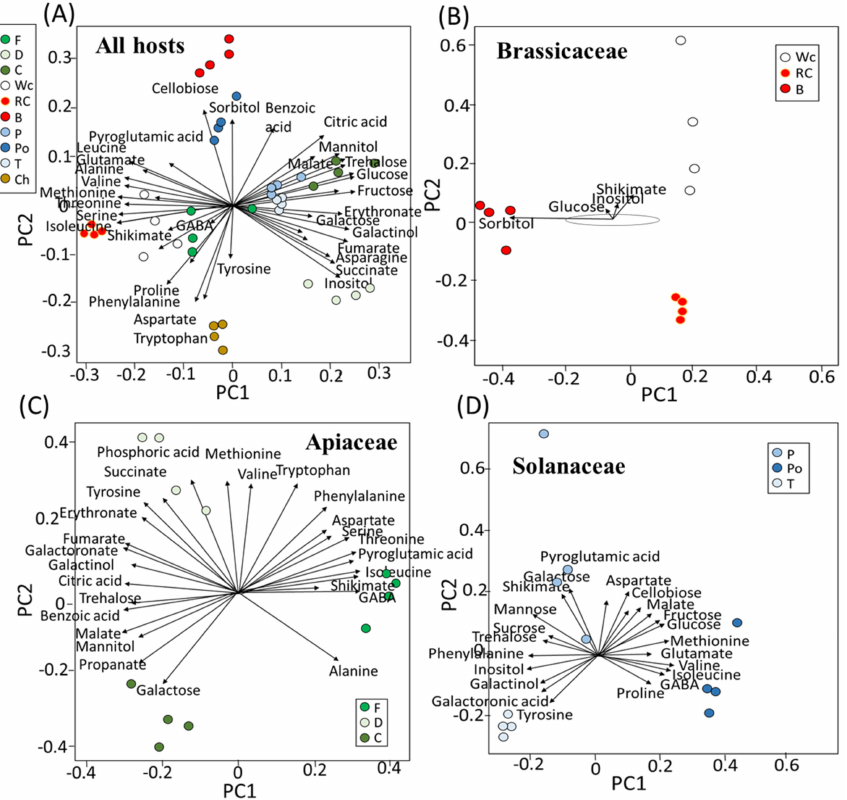
Figure 2. Biplot analyses. The length and direction of each vector represent the contribution of the metabolite to the PCA. ( A ) Metabolites from all 10 hosts and the vectors for the individual host family. Hosts that belong to the families of Brassicaceae ( B ), Apiaceae ( C ) and Solanaceae ( D ). Host plants are designated as Broccoli (B), Red cabbage (Rc), White cabbage (Wc), Potato (Po), Pepper (P), Tomato (T), Carrot (C), Dill plant (D), Fennel bulbs (F) and Chickpea